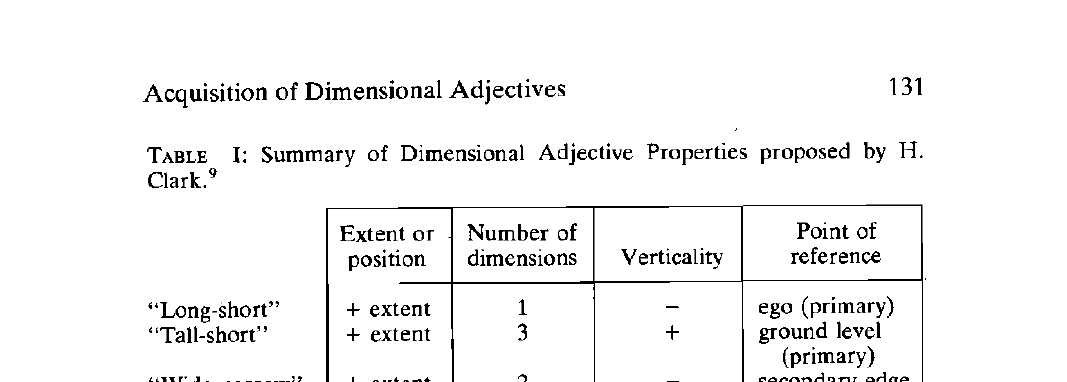
I: Summary of Dimensional Adjective Properties proposed by H. Clark.